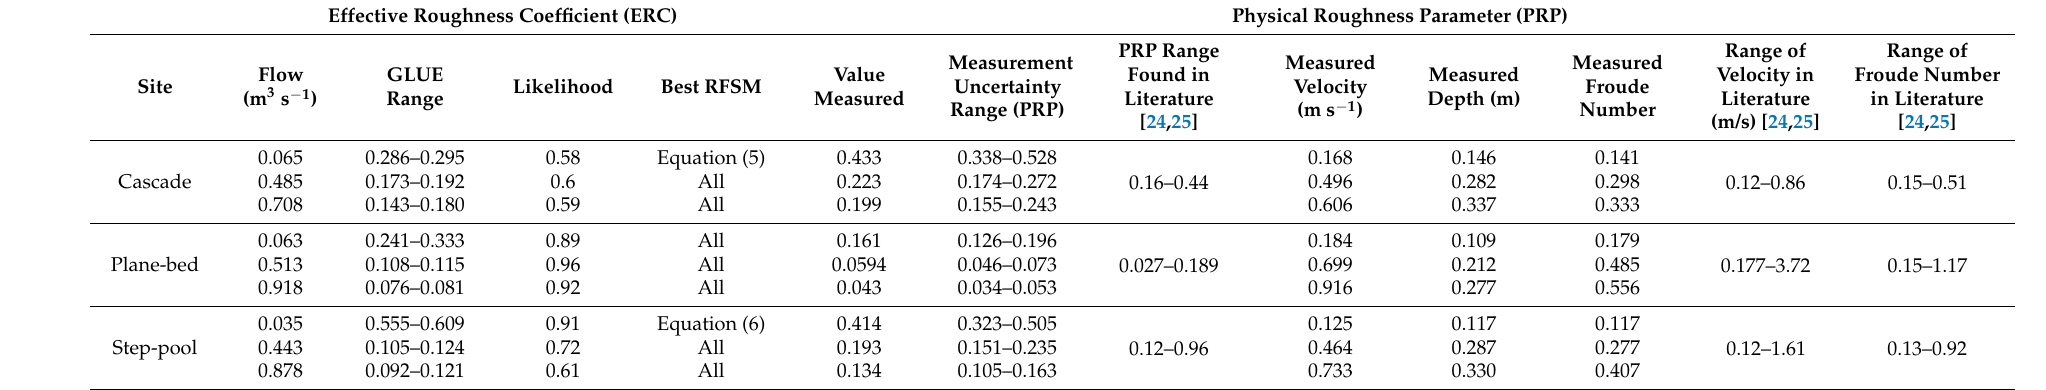
Table 1. Range of values for measured and calibrated n value for Experiment